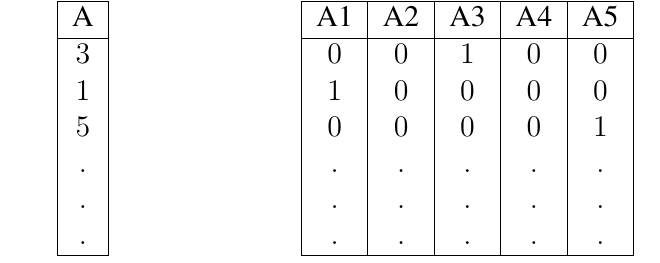
Table 1: An example of crisp coding of a categorical variable with five categories into a dummy or indicator